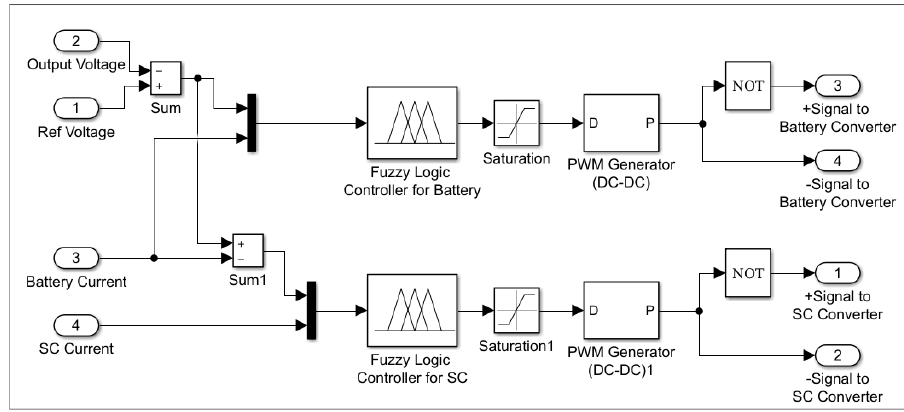
Figure 14. Control system with FLC for battery and supercapacitor.